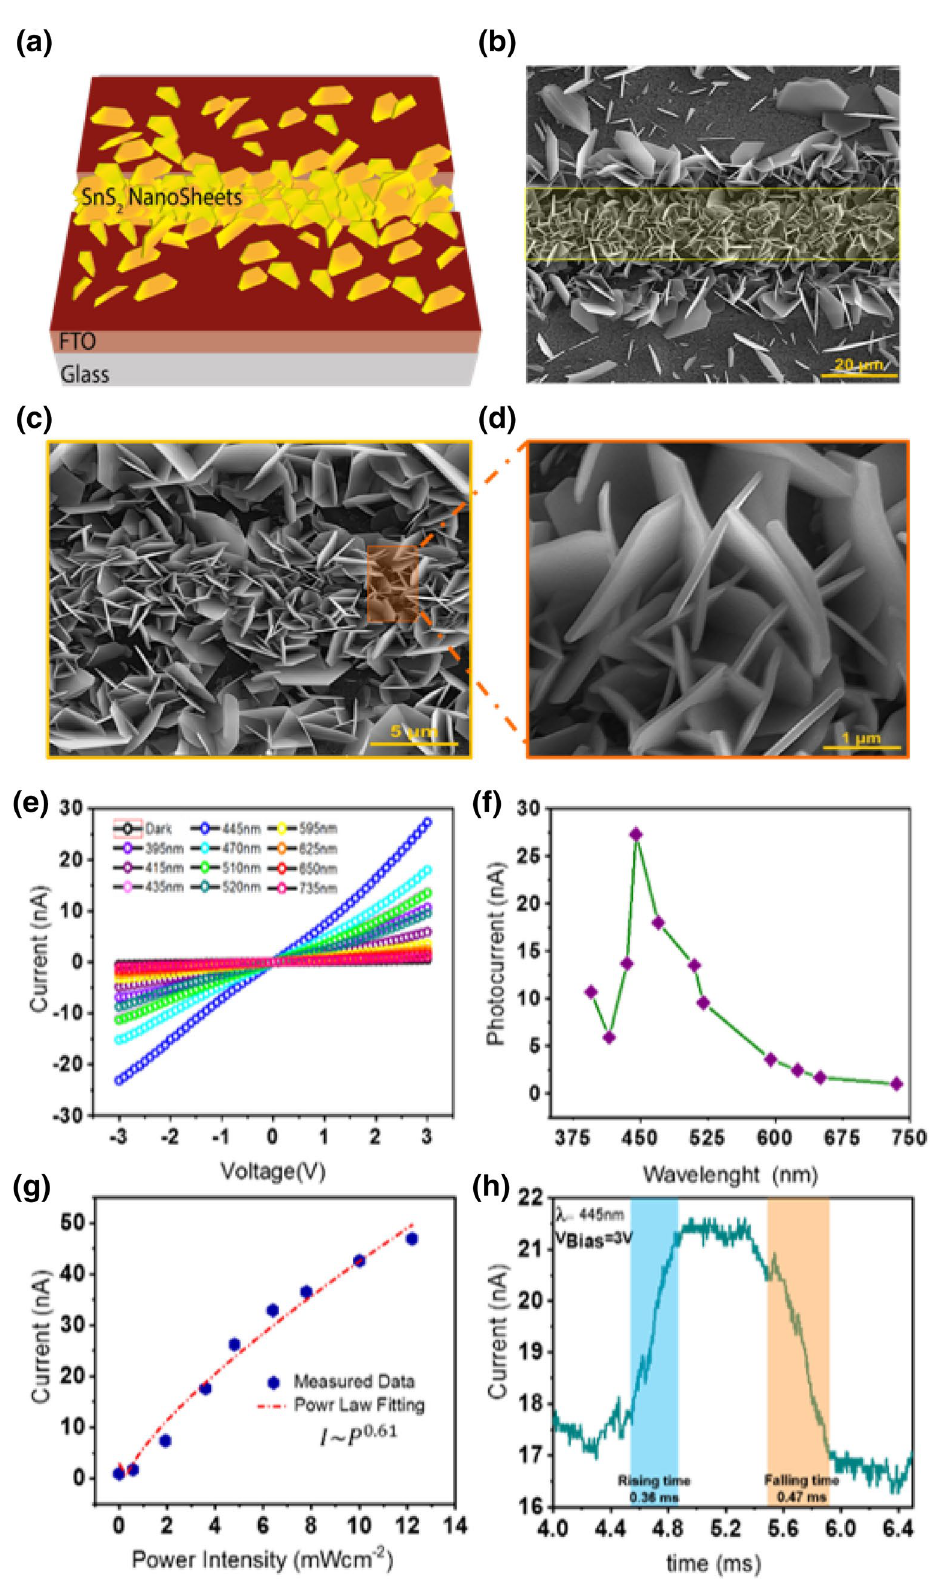
Figure 5. Pristin SnS 2 nanosheet based photodetector. ( a ) Schematic and ( b ), ( c ), ( d ) Different magnitude of FESEM analysis of grown vertically gown SnS 2 nanosheets on the laser patterned FTO through CVD process. ( e ) The evolution of current versus applied voltage ( f ) The photocurrent at 3 V bias, for different wavelength at the light intensity of 5 mW/cm 2 ( g ) Dependence of photocurrent with different light intensity of λ = 445 nm at 3 V, regarding power law fitting and ( h ) Time- resolved photoresponse at 5 mW/cm 2 light intensity of λ = 445 nm and at 3 V, for planar SnS 2